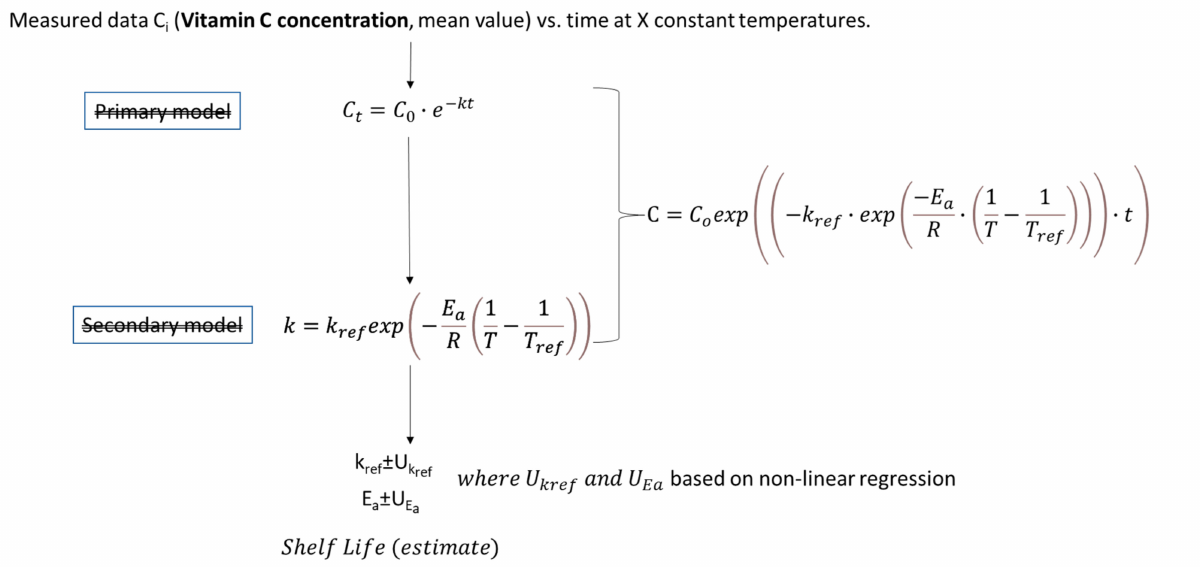
Figure 5. Indicative workflow of the global (one-step) approach (frequentist approach) using an example of the Vitamin C loss during frozen storage for vegetables, providing a mean value for the prediction of the shelf life.